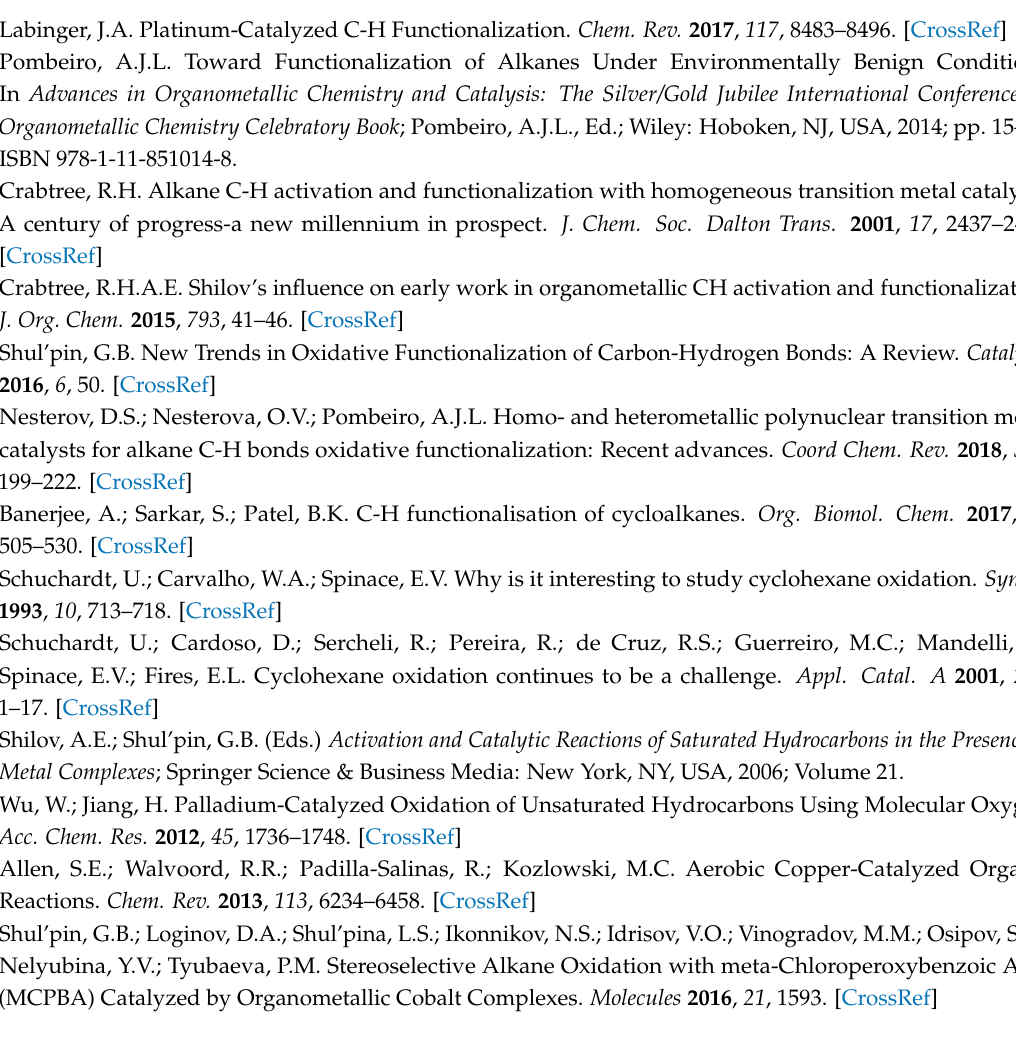
Figure S1. Example of GC chromatogram; Figure S2. Calibration line for cyclohexanone; Table S1. Species